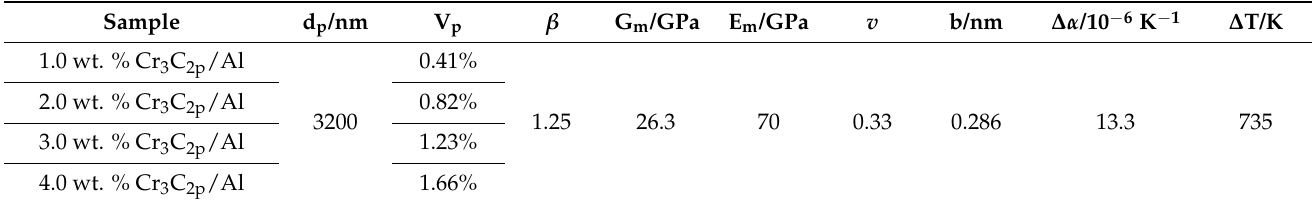
Table 1. The detailed parameter values for the CTE mismatch strengthening of the Cr 3 C 2p /Al composite.